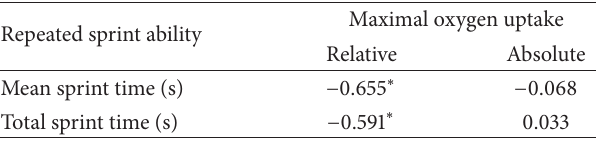
Table 2: Correlation coefficients between maximal oxygen uptake and repeated sprint ability test performance